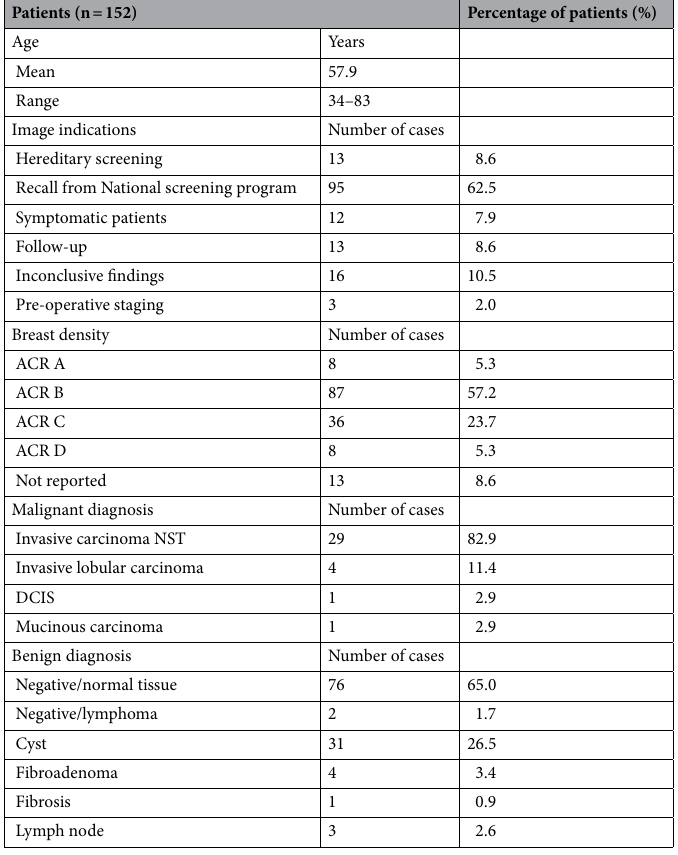
Table 1. Image indications, final diagnosis of malignant and benign cases. ACR American College of Radiology, NST No special type, DCIS Ductal carcinoma in